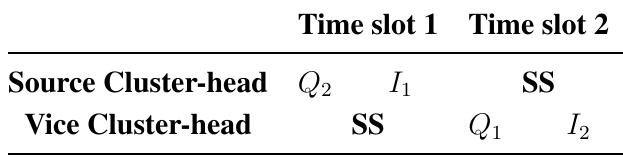
Table 2. The cooperative interleaving process for two symbols. The spectrum sensing is also used to detect the request for emergency